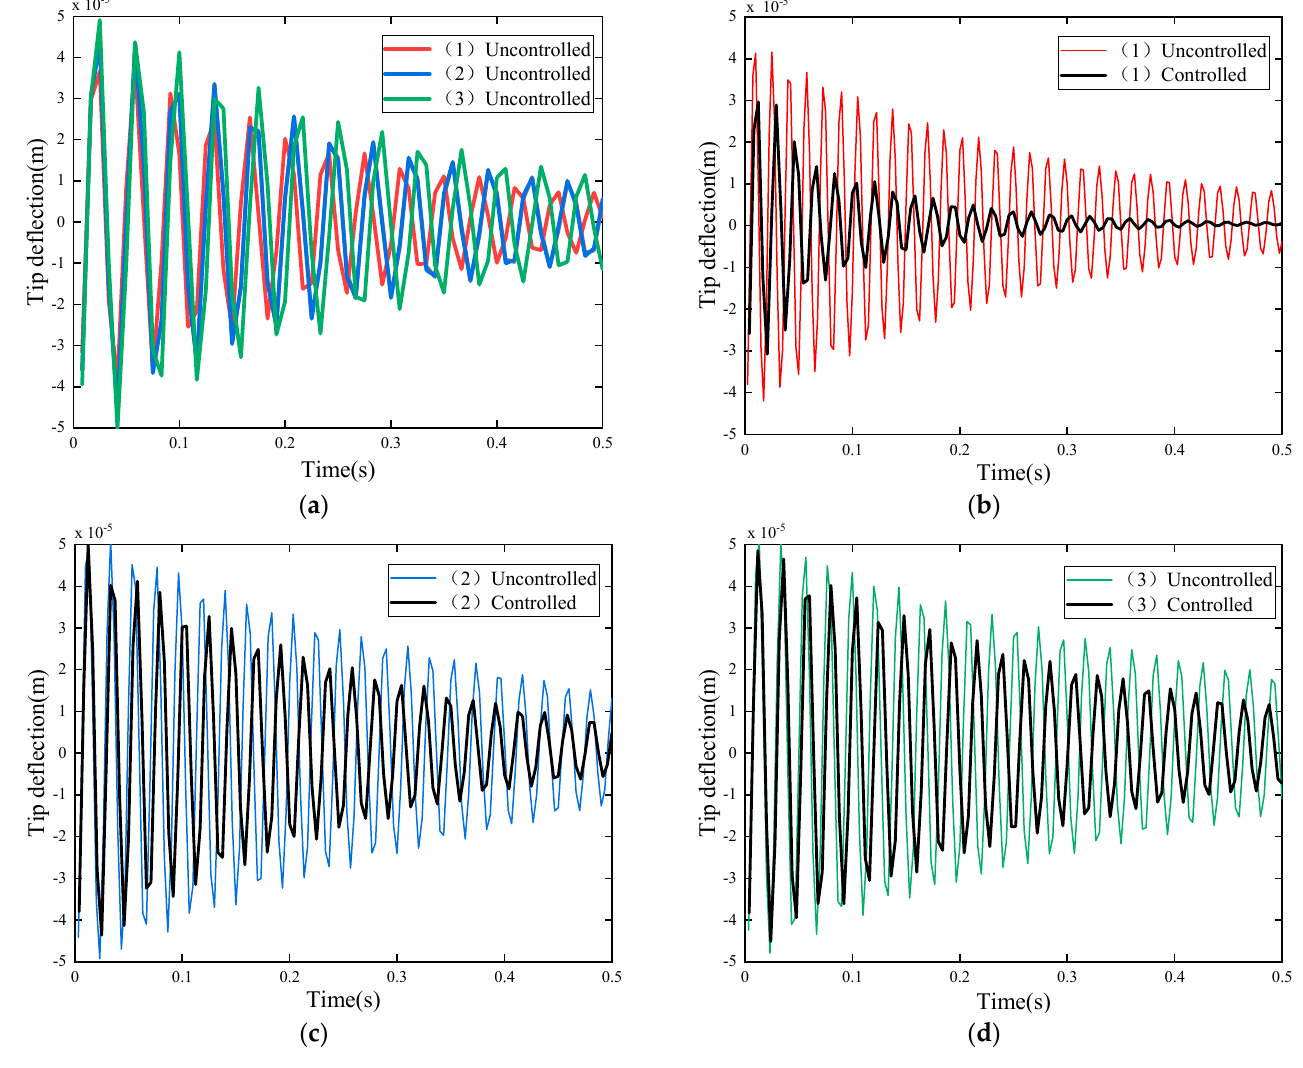
Figure 6. Comparisons of tip deflection attenuation of different structures with or without active control. ( a ) Tip deflection attenuation without active control ( b ) Tip deflection attenuation of structural (1); ( c )Tip deflection attenuation of structural (2) ( d )Tip deflection attenuation of structural (3).